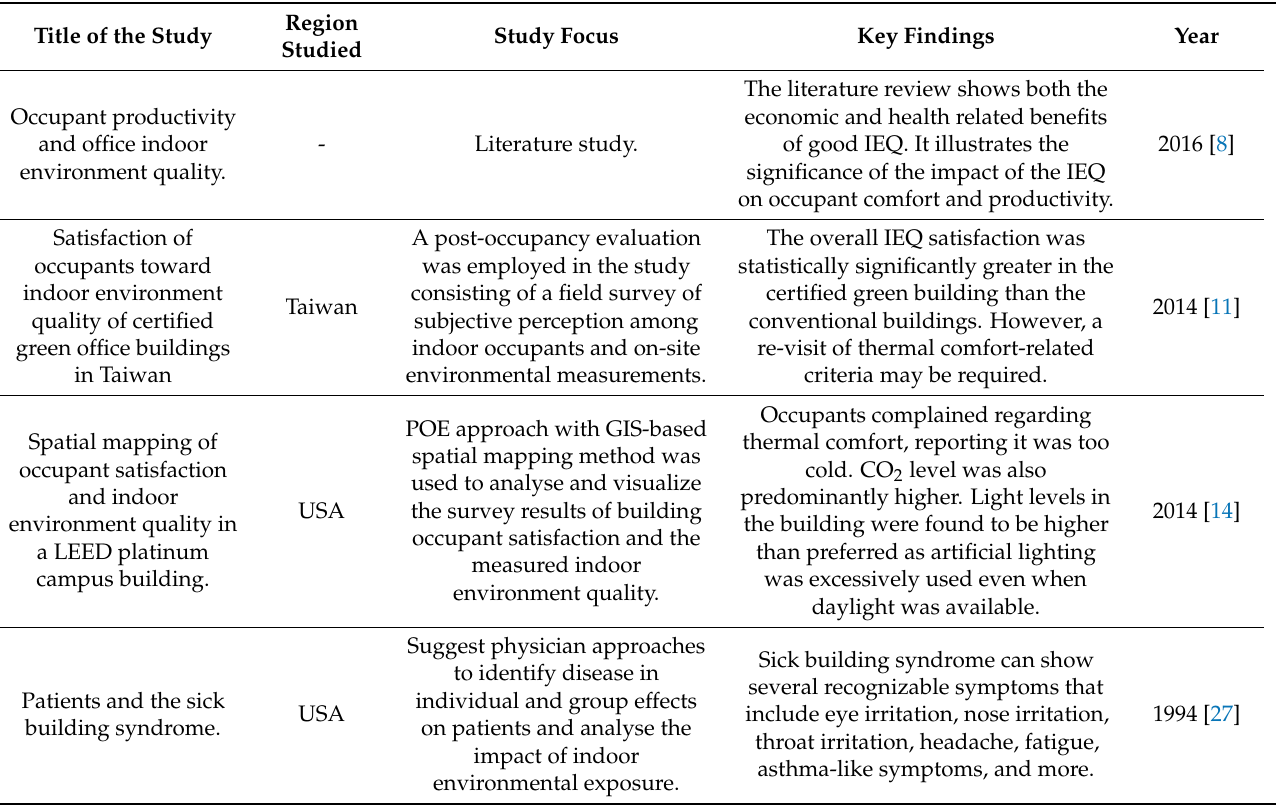
Table 1. Literature review findings on IEQ effects at the